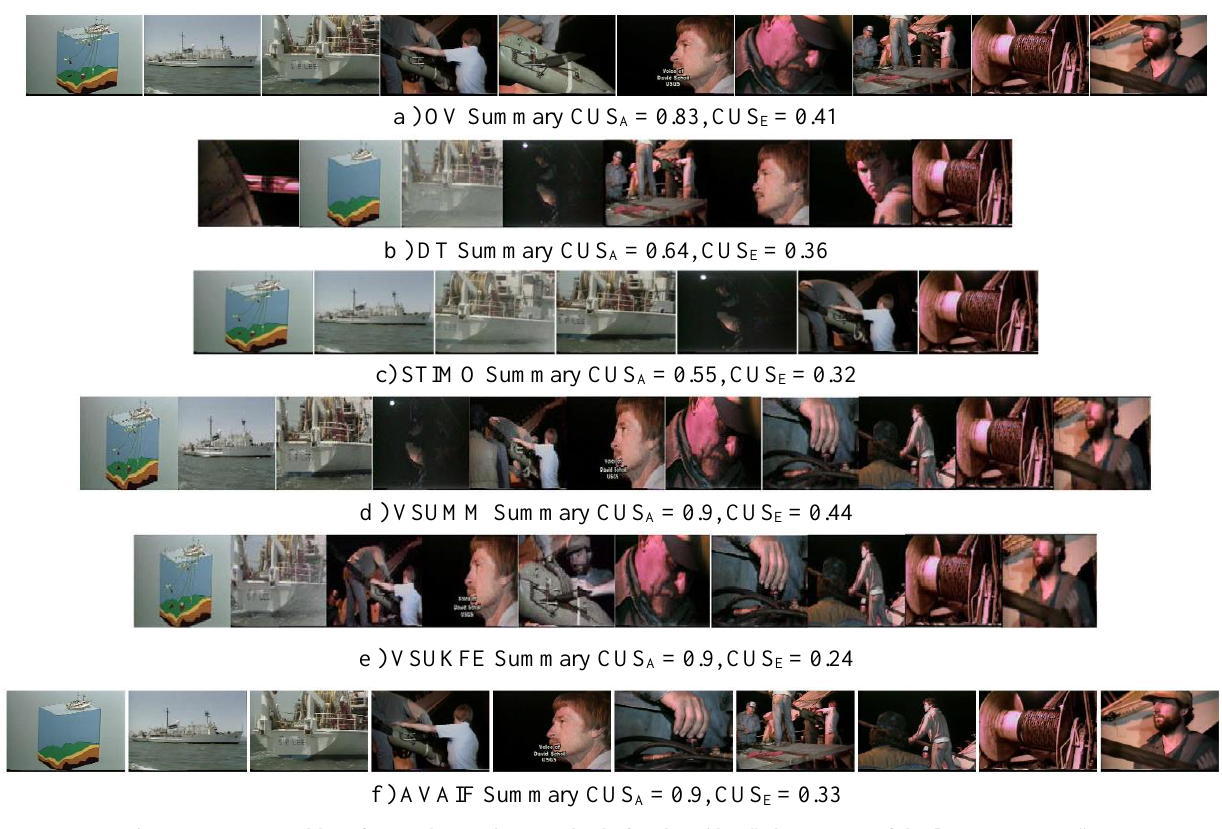
Figure 9. Generated key frames by various methods for the video " The voyage of the lee, segment 05 " .